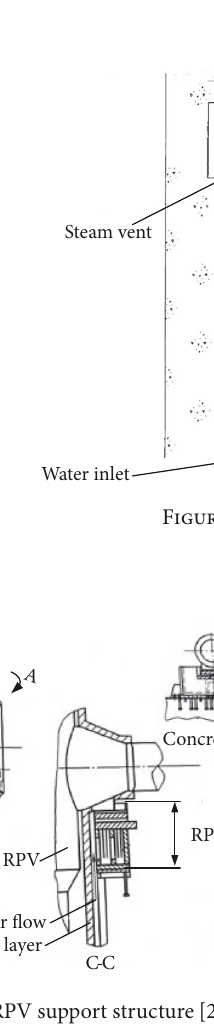
Figure 2: AP1000 RPV support structure